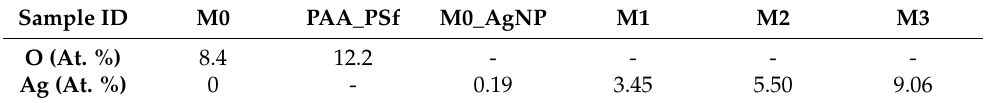
Figure 1. ( a ) FTIR spectra of polysulfone membranes (PSf) and acrylic acid modified polysulfone membranes (PAA_PSf), and ( b ) XPS spectrum for Ag (3d) of sample M2. Table 2. Atom Percentage of O and Ag on the Membrane Surfaces as Determined by XPS.